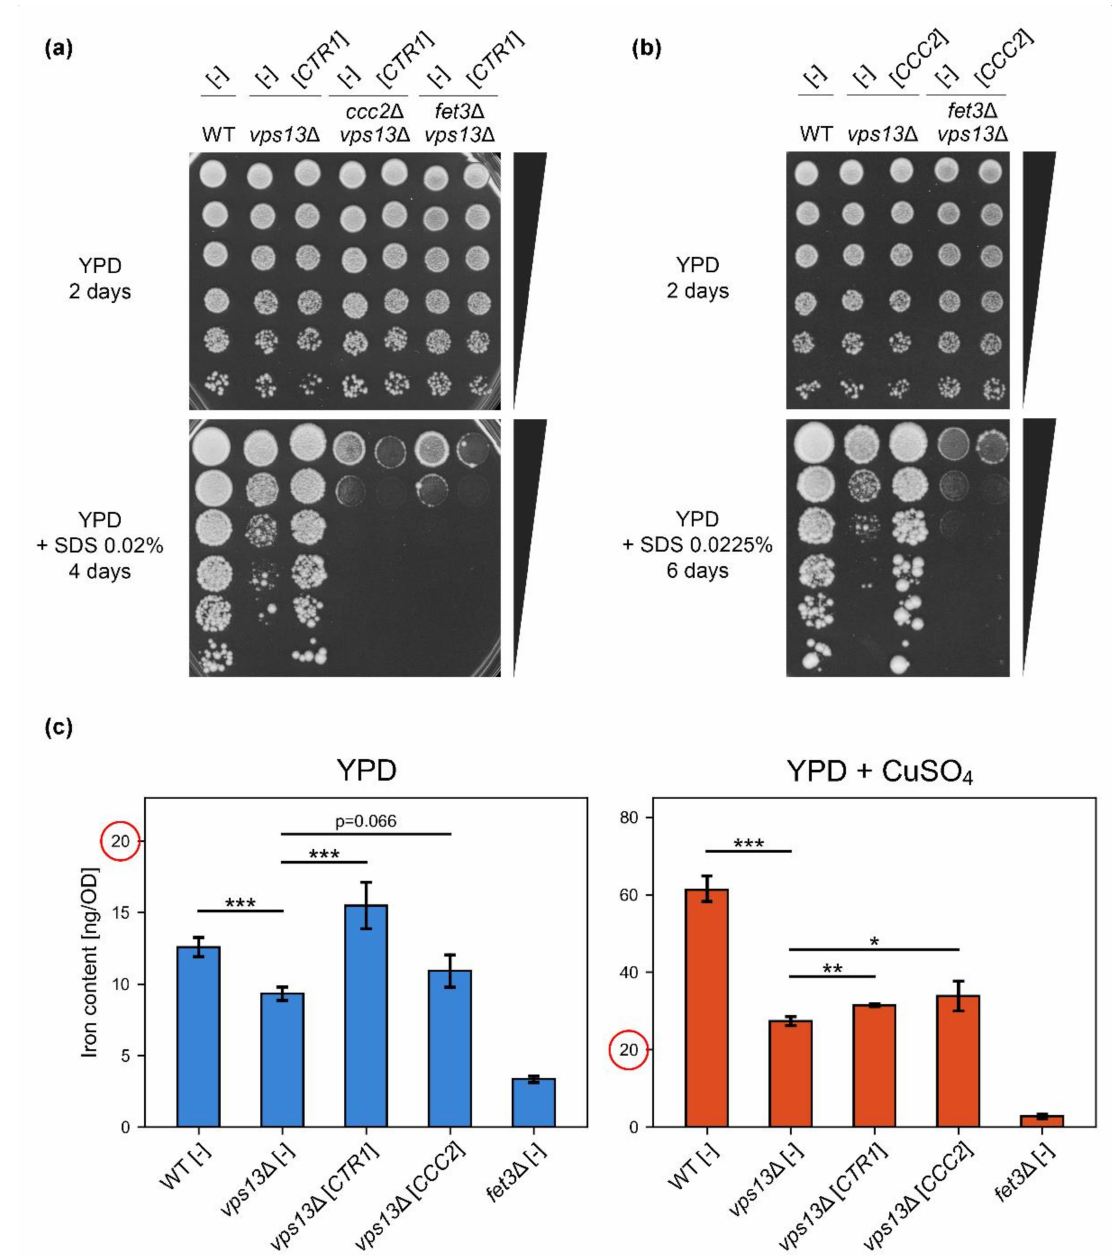
Figure 3. Copper-based suppression of vps13 ∆ SDS-hypersensitivity acts via a high-affinity iron uptake system to increase the iron level in vps13 ∆ . ( a ) Growth of wild type, vps13 ∆ , ccc2 ∆ vps13 ∆ , and fet3 ∆ vps13 ∆ strains bearing plasmid with CTR1 gene or empty vector was compared by drop test on plates with YPD and YPD + SDS media. ( b ) Growth of wild type, vps13 ∆ and fet3 ∆ vps13 ∆ strains bearing plasmid with the CCC2 gene or empty vector was compared by a drop test on plates with YPD and YPD + SDS media. ( c ) Iron levels in WT[-], vps13 ∆ [-], vps13 ∆ [ CTR1 ], vps13 ∆ [ CTR1 ], vps13 ∆ [ CCC2 ] and fet3 ∆ [-] (negative control) strains. Iron content was measured in cells of tested strains by ICP-AES. Obtained result were analysed by two-tailed Student’s t-test ( n = 4, * p < 0.05, ** p < 0.01, *** p < 0.001). Error bars represent SD. Axes are different in panels of c, indicated by red circles on the same position (20) on the